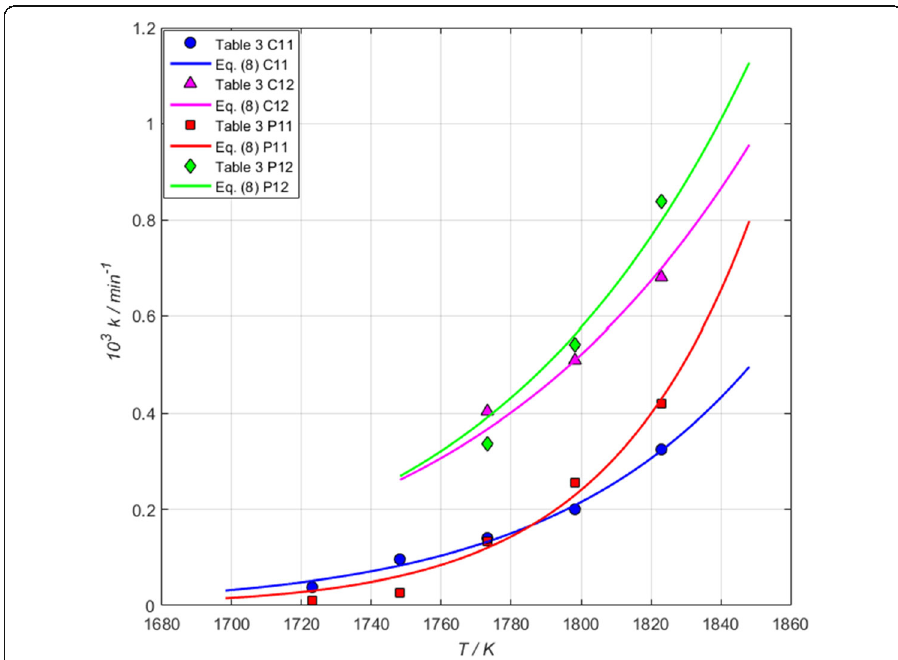
Fig. 2 The final values of k as well as curves of k(T) for reactions of MgO with carbonic reductants in different molar ratios and at temperatures 1723.15 K, 1748.15 K, 1773.15 K, 1798.15 K, and 1823.15